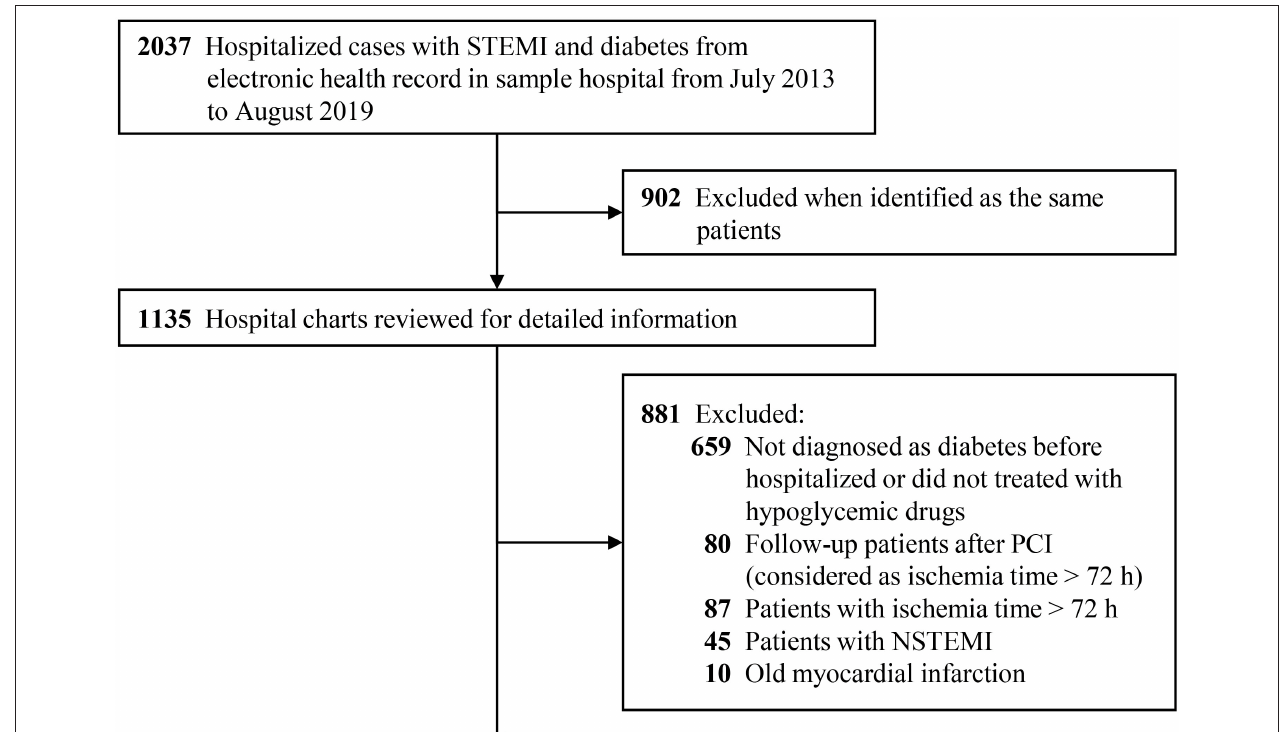
FIGURE 2 | The flow diagram of the selection process to determine eligible individuals. STEMI, ST-segment elevation myocardial infarction; NSTEMI, non-ST-segment elevation myocardial infarction; CMR, cardiac magnetic resonance imaging; PCI, percutaneous coronary intervention.